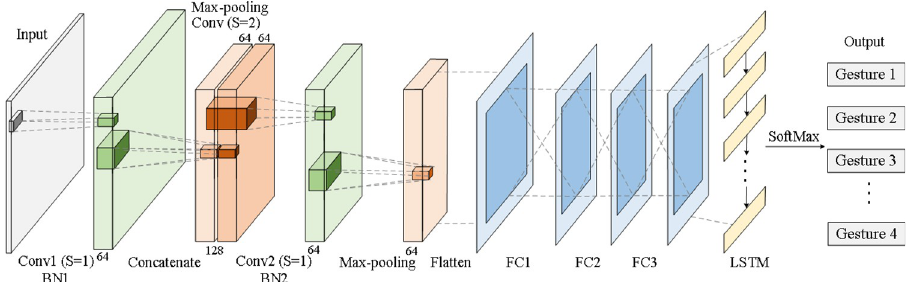
Fig 4. The structure of the